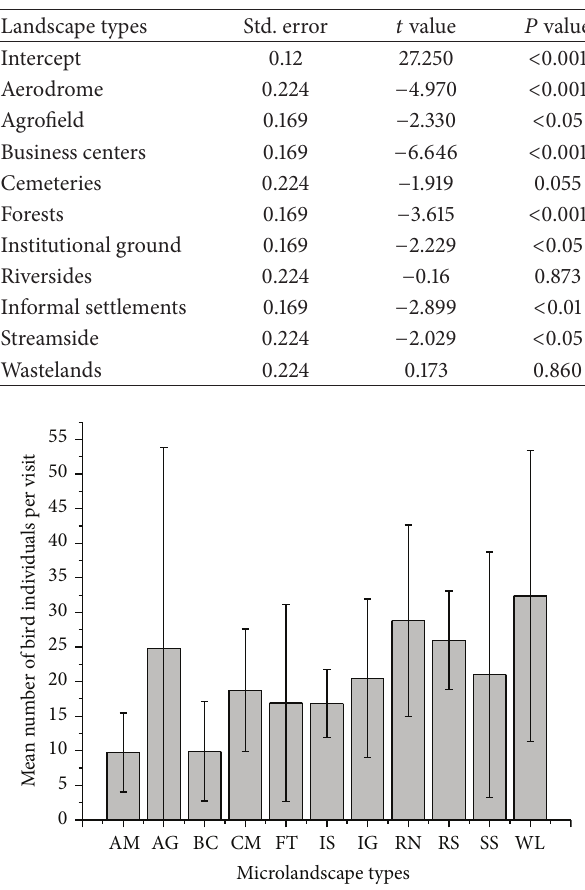
Figure 6: Mean number of bird individuals observed per